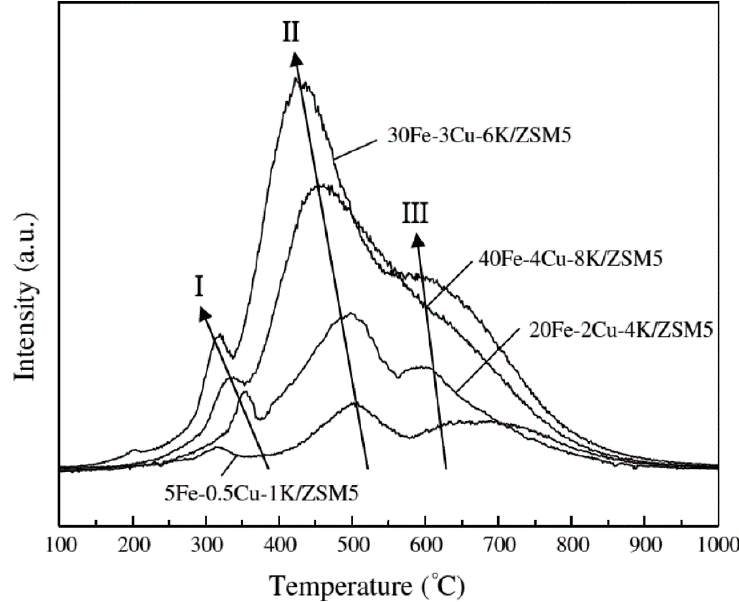
Figure 14. CO- temperature-programmed reduction (TPR) profiles of Fe–Cu–K/ZSM-5 catalysts [98].